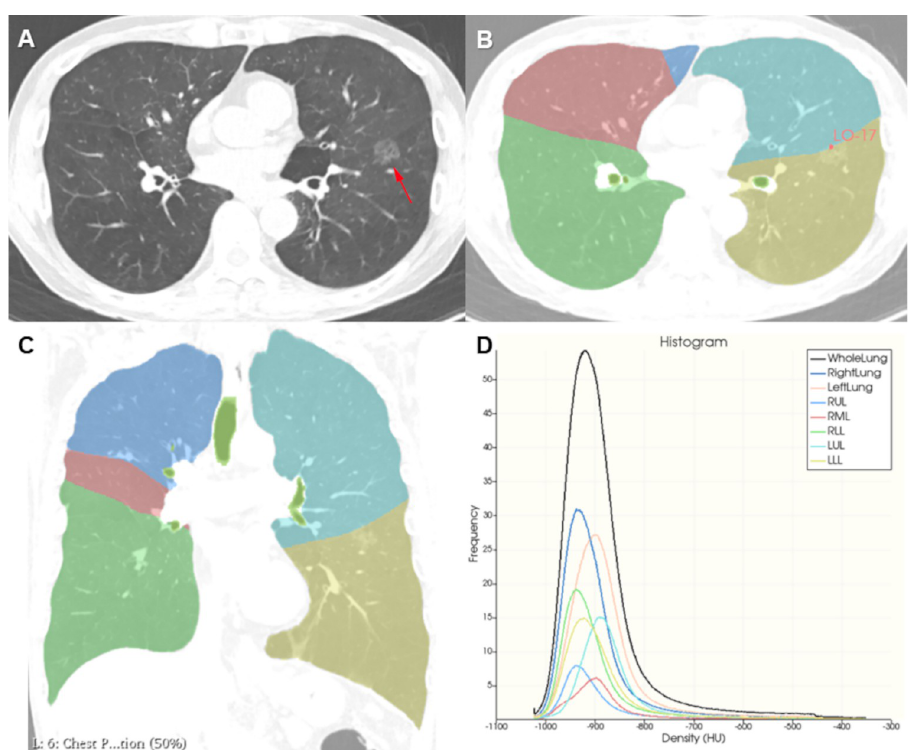
Fig 1. The process of pulmonary lobe segmentation and emphysema quantification using 3D Slicer software. (A) 58-year-old man with a 19 mm mixed ground glass opacity nodule (arrow) in the left lower lobe. (B, C) The pulmonary lobe is successfully extracted after marking each pulmonary fissure using the “interactive lobe segmentation” module. The right upper lobe, right middle lobe, right lower lobe, left upper lobe and left lower lobe in axial and coronal images were displayed in the blue, red, green, turquoise and yellow colors, respectively. (D) The ratios of emphysema in both lungs and each pulmonary lobe were automatically analyzed using the “parenchymal analysis” module. The lung densities in whole lung and each pulmonary lobe were presented using the density histogram analysis. The lobar emphysema ratio in the left lower lobe was 16.591, and he was confirmed to have adenocarcinoma after